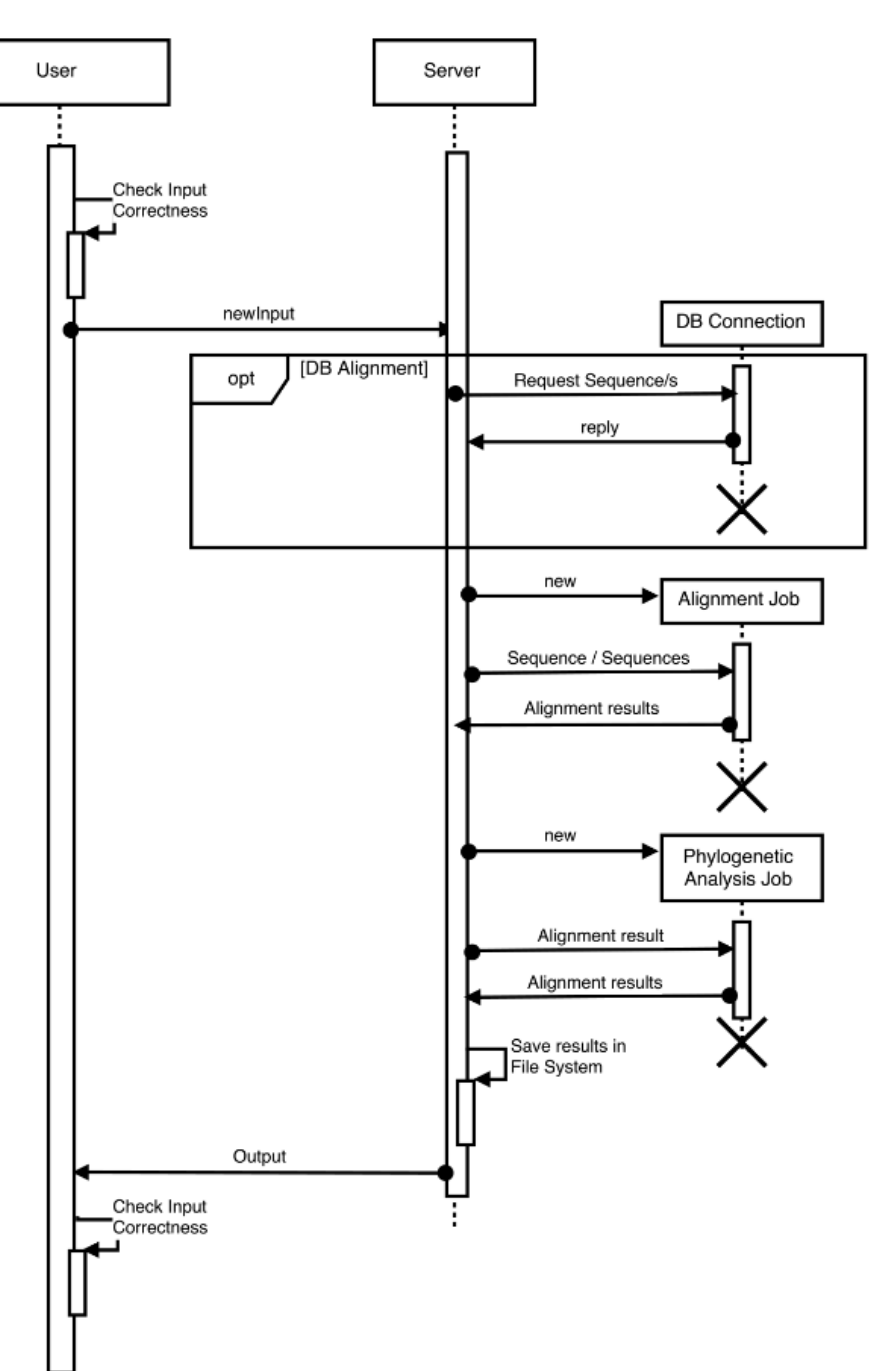
Figure 2. Sequence diagram for the phylogenetic analysis module.